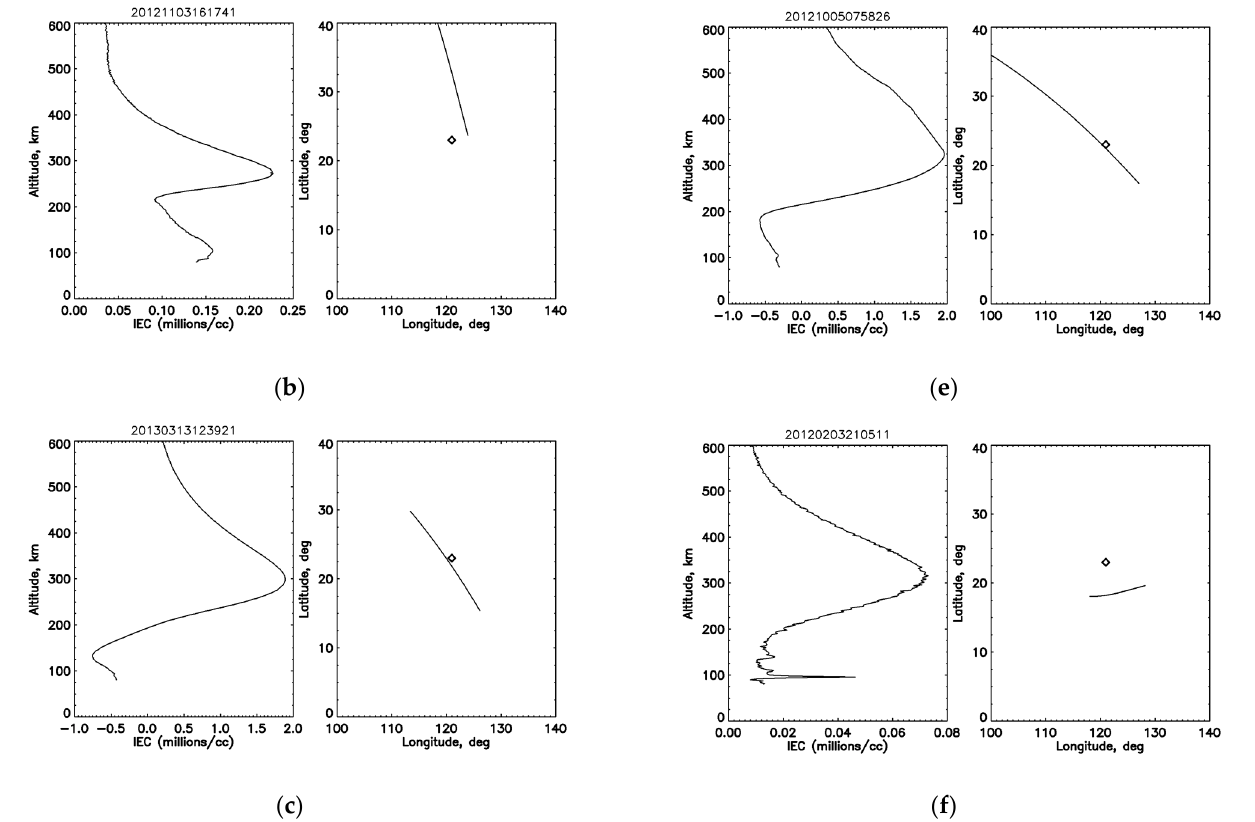
Figure 5. This figure is the same as Figure 1 but for samples with misclassification: ( a ) F2 class was predicted as F2F1 class; ( b ) F2E class was predicted as Sc class; ( c ) F2ED class was predicted as F2F1 class; ( d ) F2F1 class was predicted as F2ED class; ( e ) F2F3 class was predicted as F2ED class; ( f ) Sc class was predicted as F2E class.